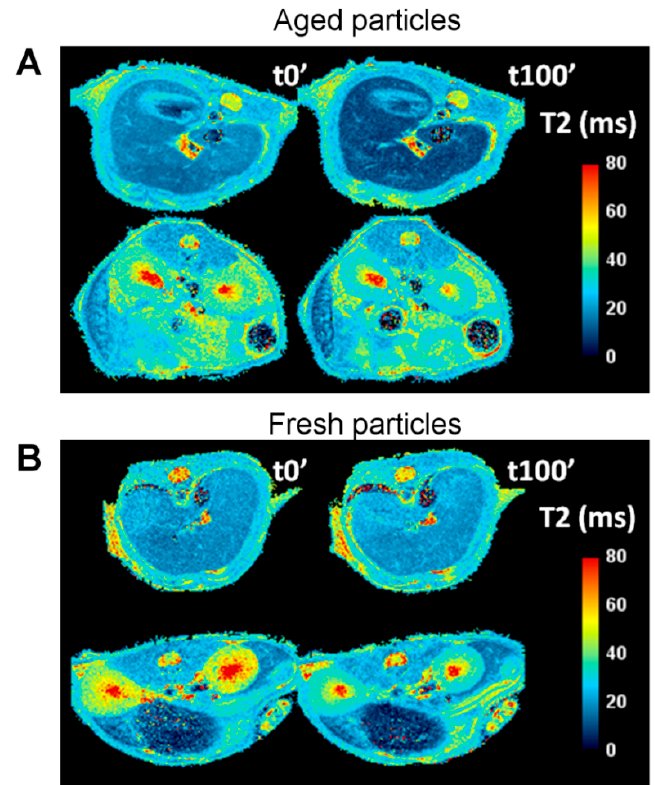
Figure 5. T2 relaxation maps at two different locations of the abdomen of a mouse showing the liver (top rows in both images) and the spleen and the kidneys (bottom row in both images). Two different time points are presented to reflect the changes in T2 values before (t0 ′ ) and 100 min after (t100 ′ ) the injection of the aged IONPs ( A ) and fresh IONPs ( B ).